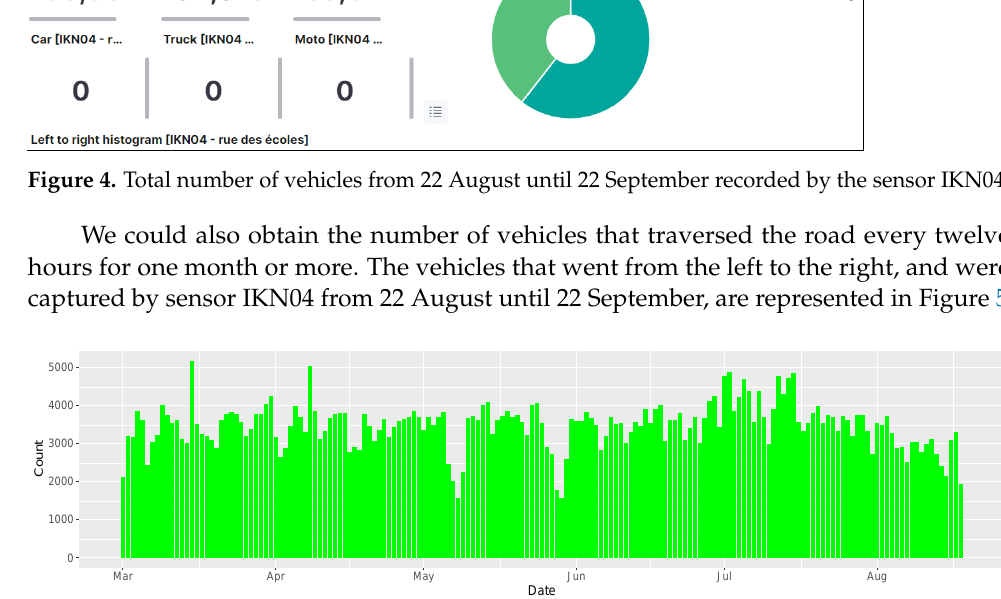
Figure 5. Count of vehicles recorded by the IKN04 sensor from 22 August until 22 September.